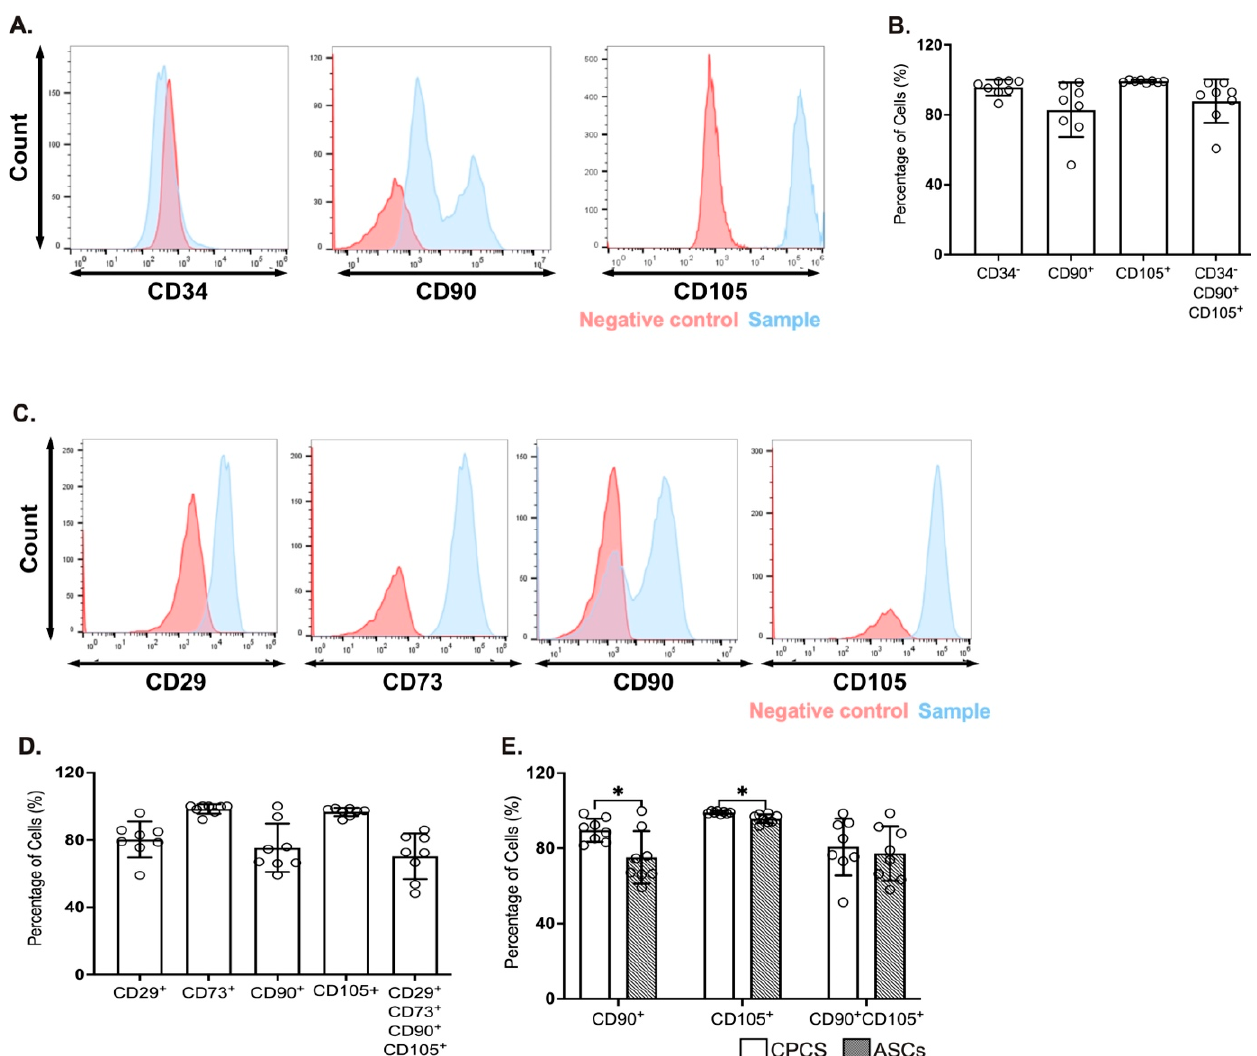
Figure 1. Surface markers for CPCs and ASCs. ( A,C ) Representative histograms showing the expression of CPC markers (CD34, CD90 and CD105) ( A ) and ASC markers (CD29, CD73, CD90 and CD105) ( C ); ( B,D ) Quantitative scatter plot column graph showing the percentage of CPC ( B ) and ASC ( D ) surface markers. ( E ) Quantitative scatter plot column graph showing the percentage of cells expressing the established MSC markers CD90 and CD105; * p < 0.05. Data are represented as mean ± SEM (n = 8 in each group).